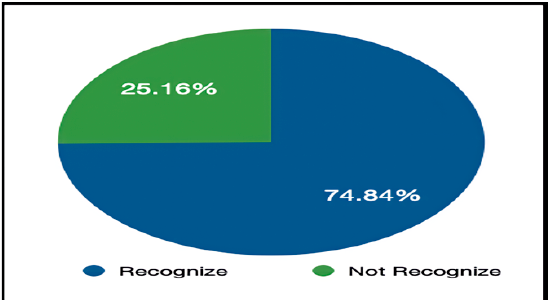
Figure 12. Face recognition percentage in the published photos.